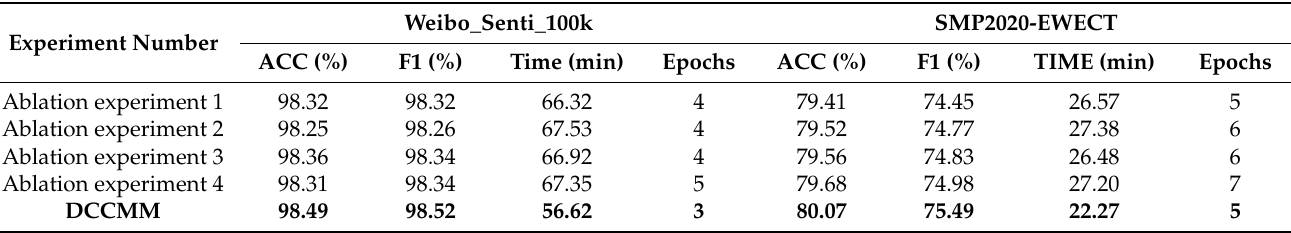
Table 8. Ablation Experimental Model Performance